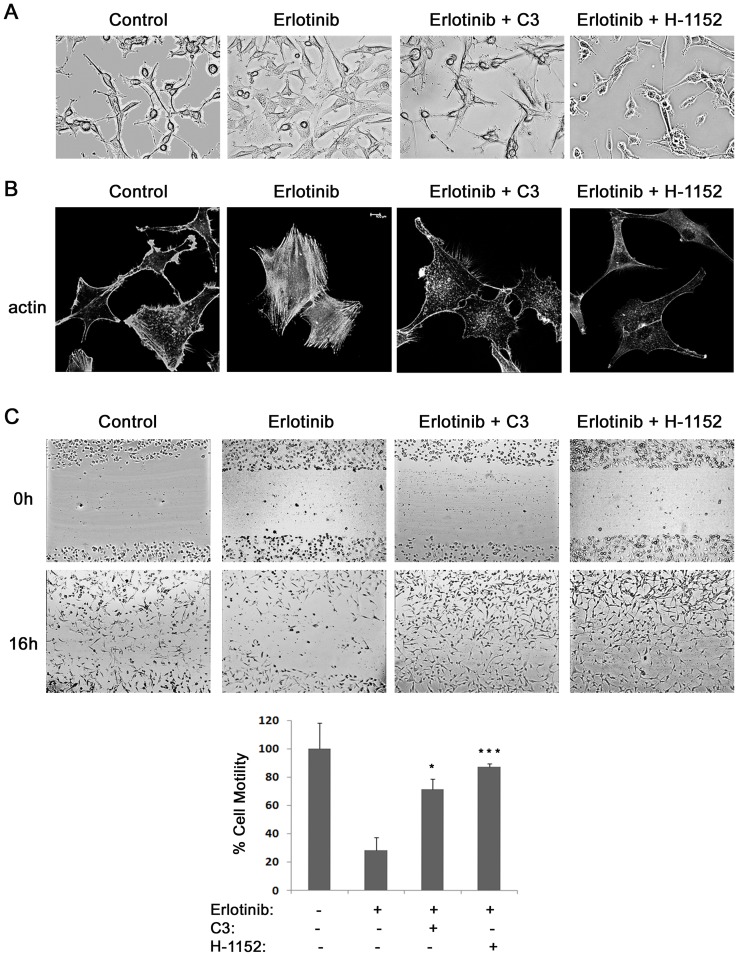
Erlotinib-induced effects on cell morphology and motility require Rho/ROCK activity.(A) Representative phase-contrast micrographs of U87MG cells left untreated (control) or treated for 24 h with 10 µM erlotinib alone or in the presence of 0,5 µg/ml C3 or 0,5 µM H-1152. (B) U87MG cells grown on coverslips were left untreated (control) or were treated for 24 h with 10 µM erlotinib alone or in the presence of 0,5 µg/ml C3 or 0,5 µM H-1152, fixed and stained with TRITC-labelled phalloidin. Bar, 10 µm. (C) Representative phase-contrast micrographs of U87MG cells left untreated or treated as indicated, before (upper panel) and after (lower panel) performing wound healing assays as described in Materials and Methods. The graph represents the mean ± SD rate of motility, from three independent experiments performed in sextuplicate, expressed as the percentage of U87MG cell motility relative to untreated cells. The differences in motility between cells treated alone with erlotinib or together with C3 or H-1152 are statistically significant (Student's t-test: *P<0.05 and ***P<0.001, respectively).